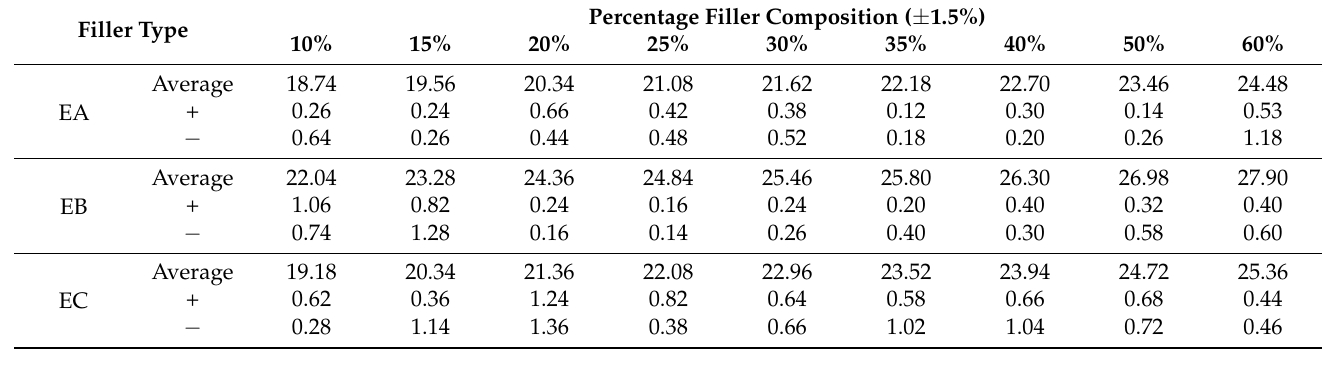
Table 7. Summary of Vickers hardness values for EA, EB, and EC.